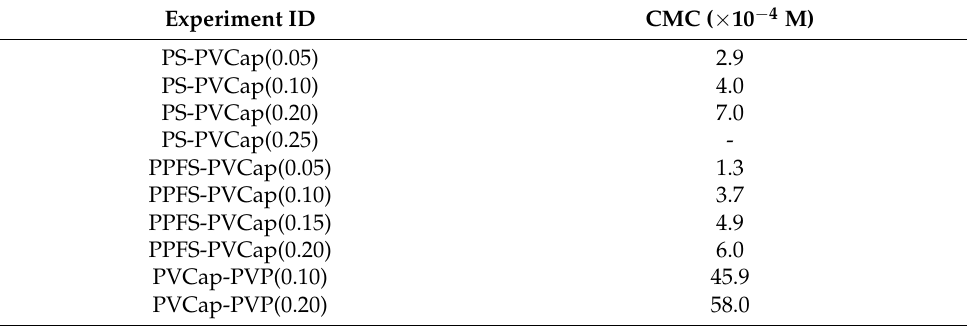
Table 5. Critical micelle concentration (CMC) of synthesized block